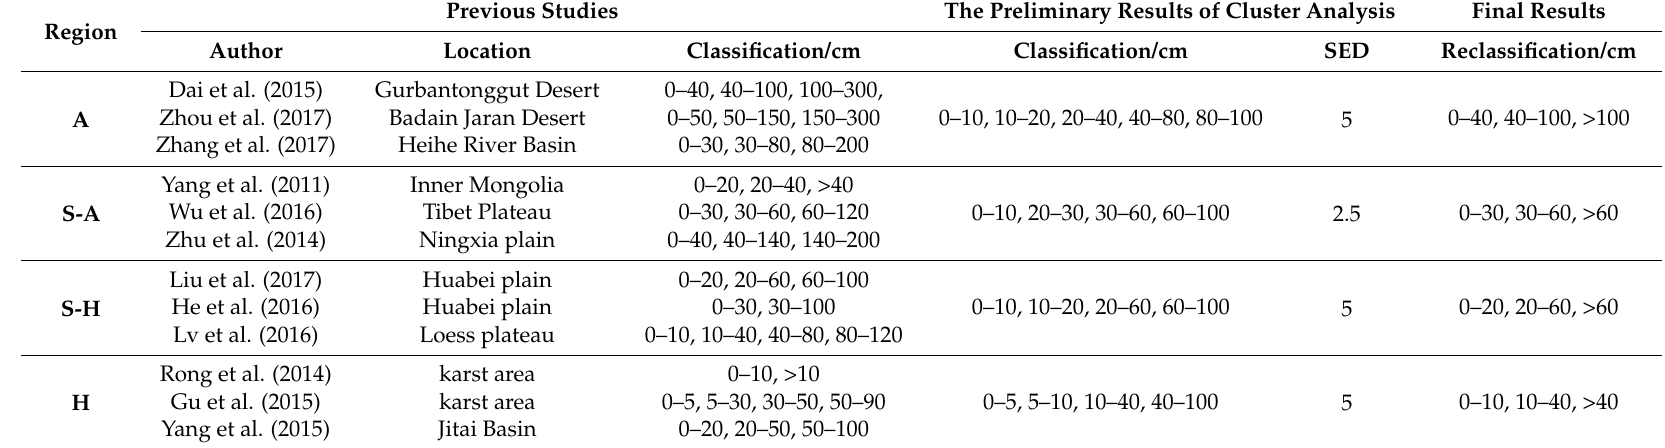
Table 2. The results of our soil